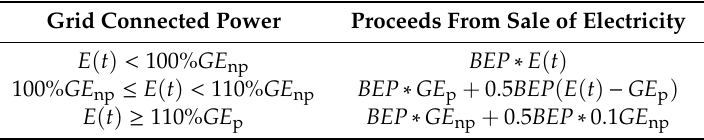
Table 5. The rules for selling electricity at o ff -peak